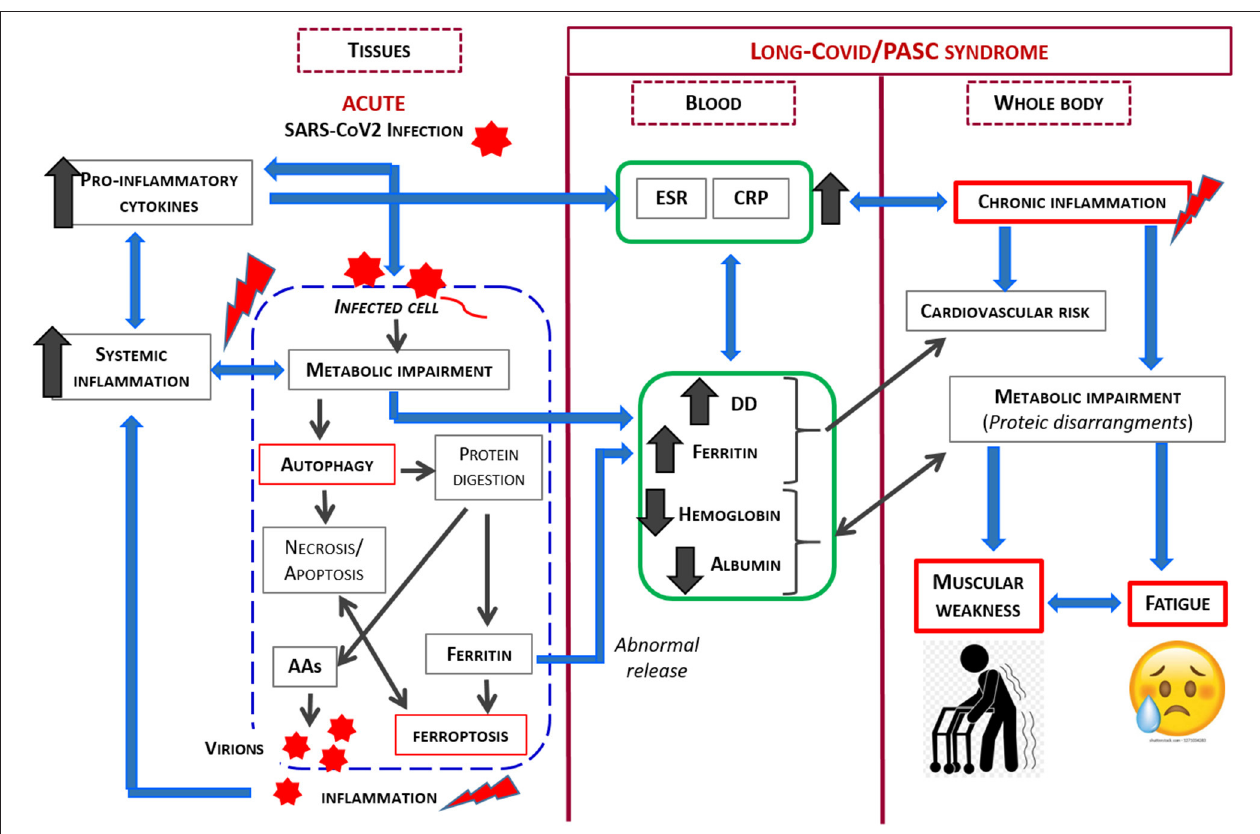
FIGURE 2 | Schematic representation of the link between SARS-CoV2 infection and metabolic impairment in infected cell and Long- COVID /PASC